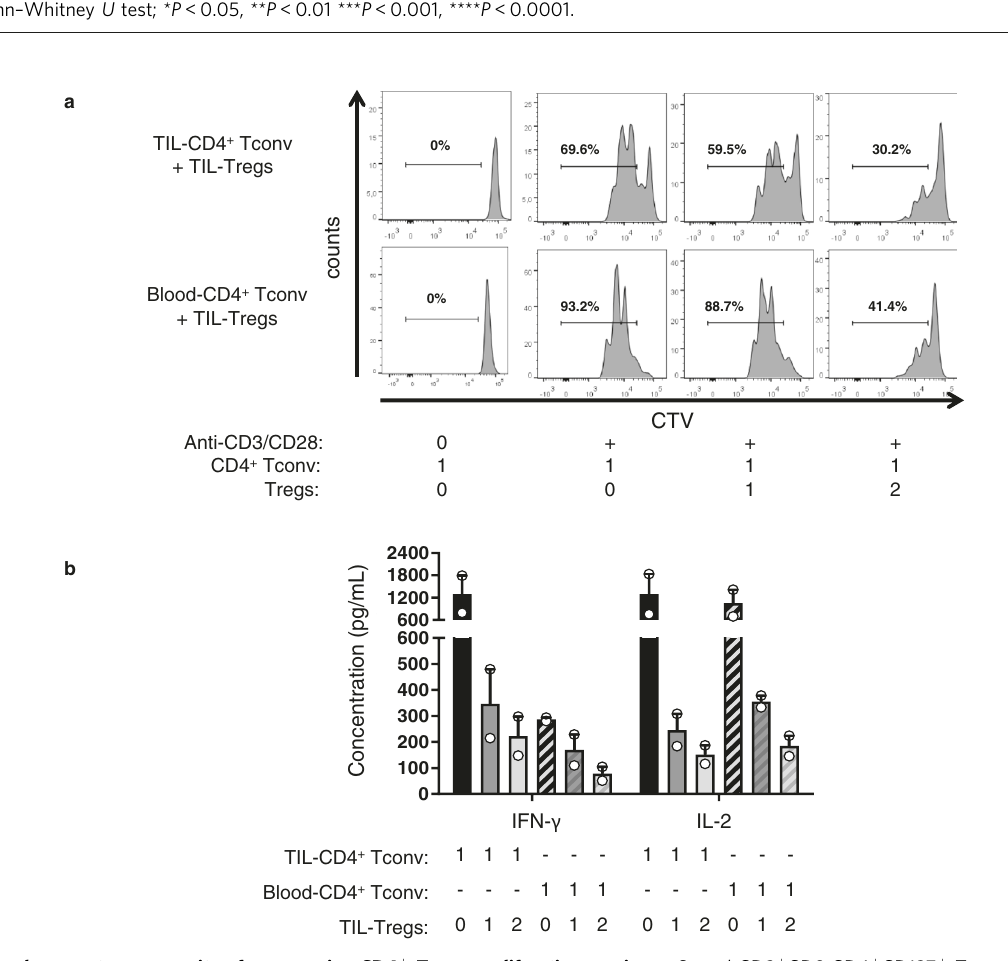
Fig. 5 Selective molecular and protein pattern of Tregs versus CD4 + Tconv in fi ltrating TLS and non-TLS areas of NSCLC tumors. a – c The gene expression in terms of log2 fold change values for the sorted Tregs and CD4 + Tconv cells from TLS and non-TLS areas of lung tumors ( n = 20 patients). The volcano plot shows genes over-expressed in a sorted TLS-Tregs (right) in comparison to sorted TLS-CD4 + Tconv (left), b non-TLS Tregs (right) versus sorted non-TLS CD4 + Tconv (left), and c TLS-Tregs (right) versus non-TLS Tregs (left) in lung tumors. The X -axis shows the log2 fold change values for each gene, and the Y -axis shows the – log10 ( P -values). The P -value < 0.05 (Student ’ s t test) is considered signi fi cant, and genes showing a signi fi cant differential expression are highlighted in red dots. The red dots showing log2 fold change values higher than 1.2, are considered as signi fi cantly differentially expressed genes and are highlighted by their gene name in blue color. d Percentage of Tregs (black circles) and CD4 + Tconv (gray circles) expressing activation markers ( n = 18 tumors) and ICP ( n = 14 tumors) at the protein level. e Illustration of the expression of CXCR3 on tumor-in fi ltrating CD3 + CD4 + CD8 - CD127 + T-bet + Th1 T cells and CD3 + CD4 + CD8 − CD127 − FoxP3 bright CD25 bright Tregs. Data are represented as median with interquartile range.